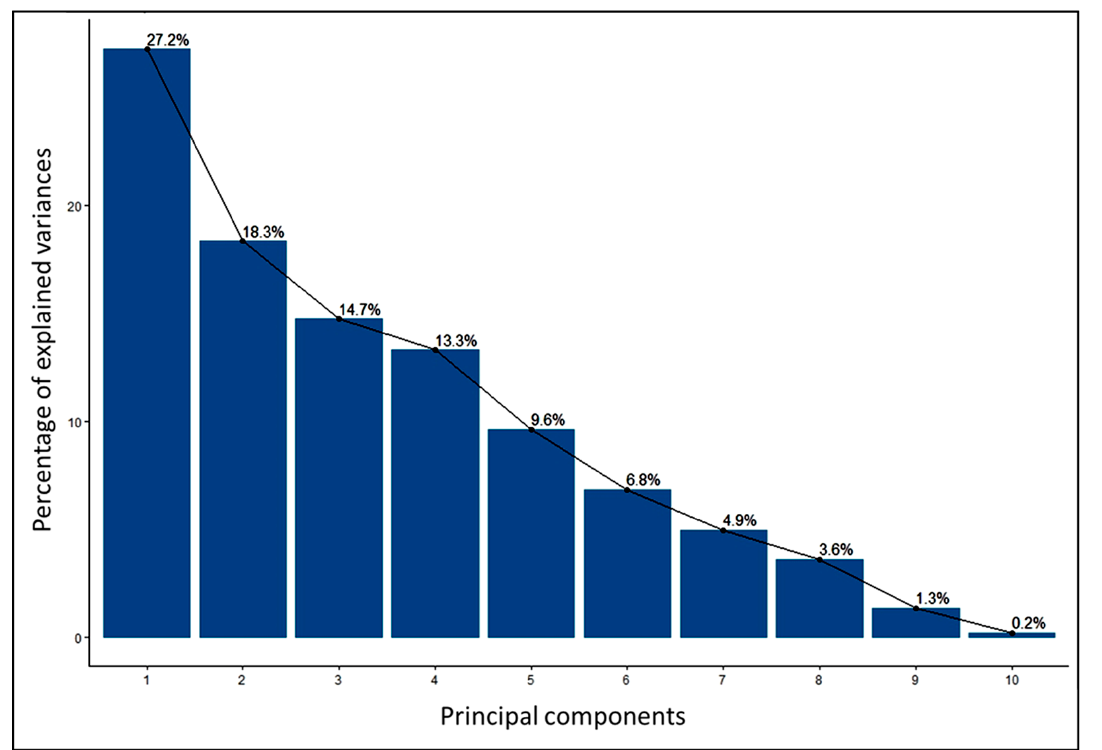
Figure 2. Scree plot on variability explained by each component of 34 elite rice genotypes.